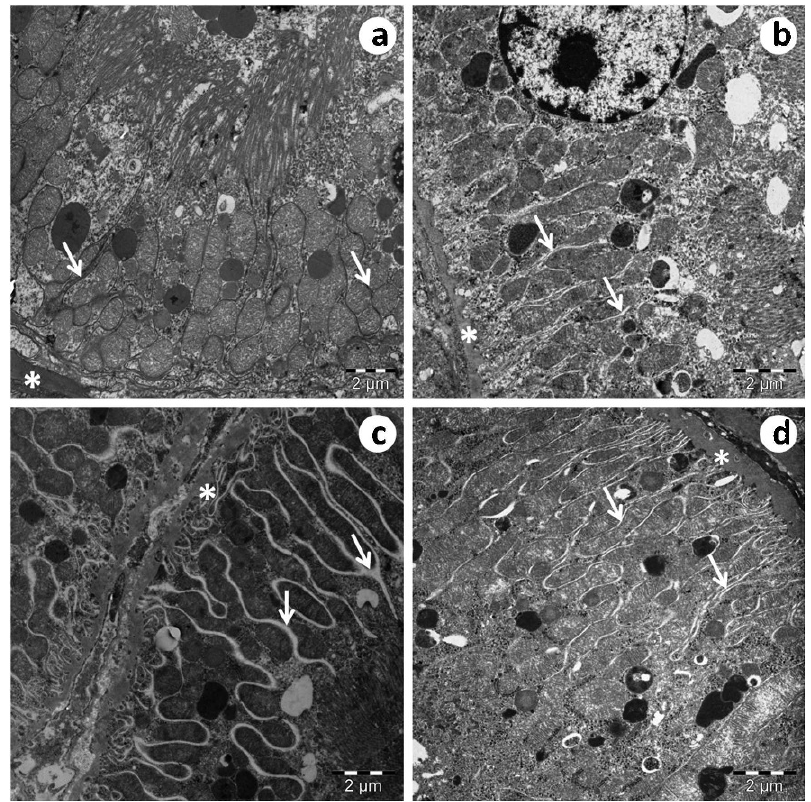
Figure 3 - An electron micrograph of a convoluted proximal tubule. In the SED-SHR (c), there is an increase in the space between the interdigitations (arrow), and the basal membrane (*) of the tubules exhibit a thickened appearance compared to the EX-SHR (d) and the SED-WKY (a) and EX-WKY (b)